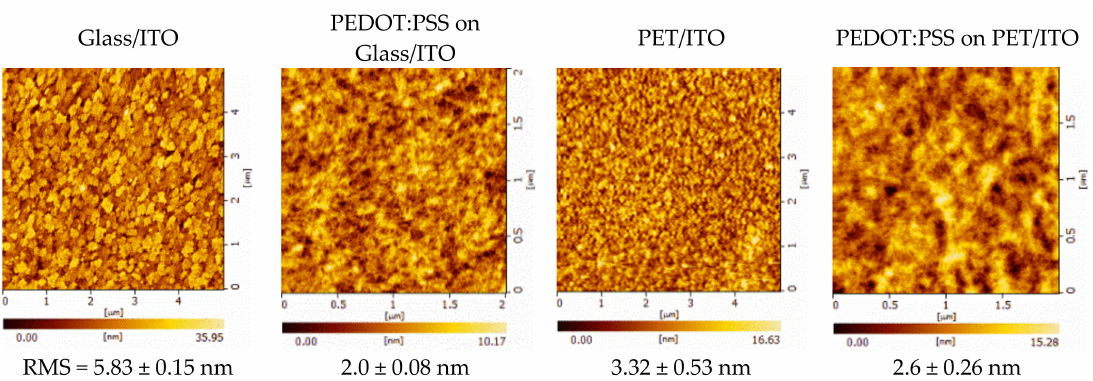
Figure 3. AFM height images and RMS roughness of glass/ITO and PET/ITO substrates and the pristine PEDOT:PSS films, spun on those substrates. The corresponding phase images of PEDOT:PSS films are shown in Figure S2 of supporting